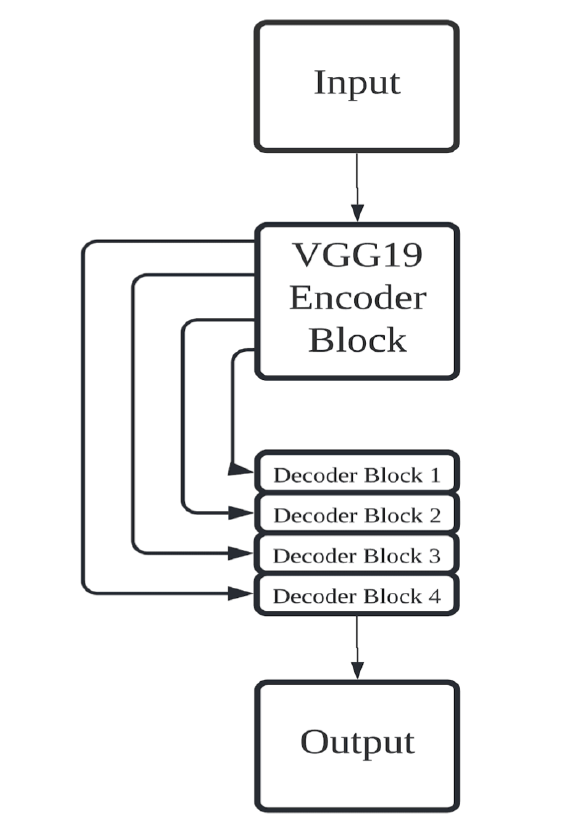
Figure 2. VGG-19-based encoder-decoder